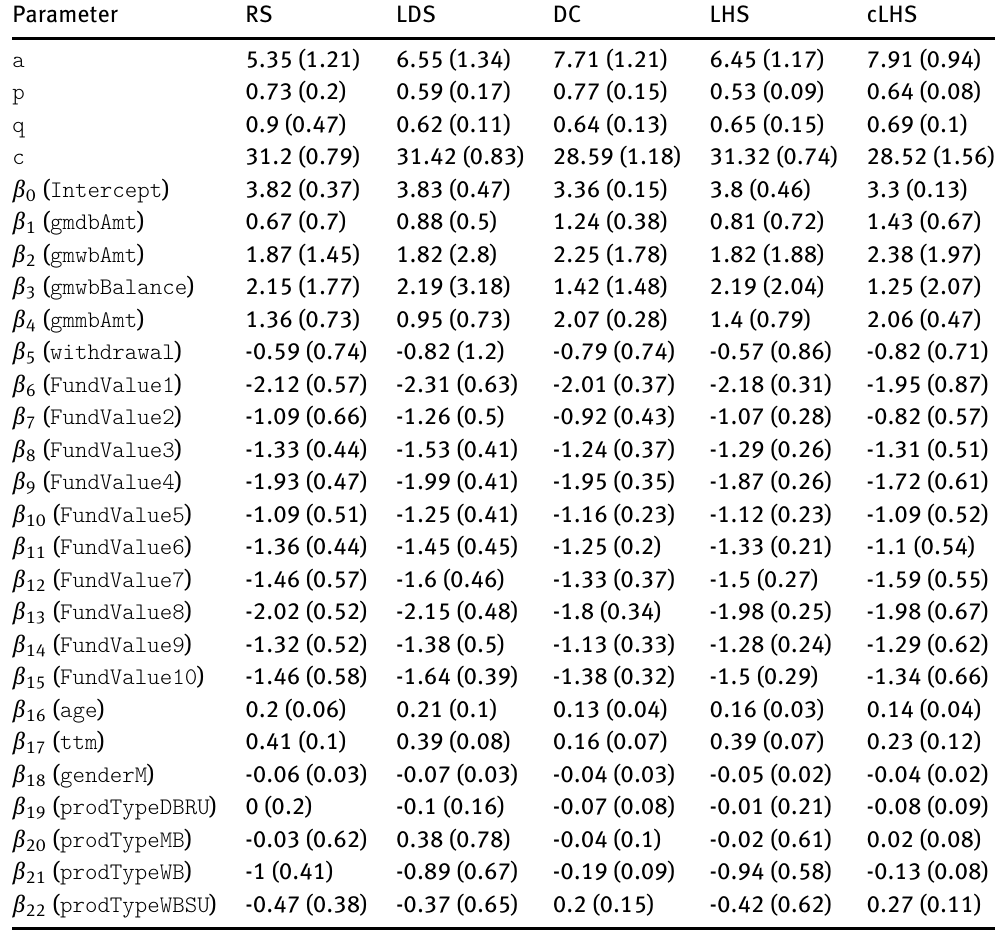
Table 7: The average and standard deviation of the estimated parameters of the GB2 model over 10 runs when s = 880